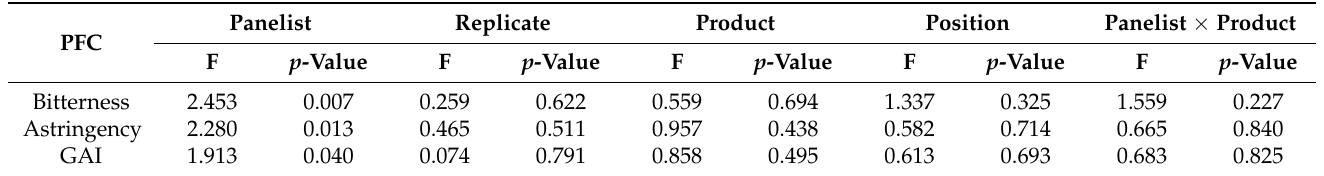
Table 3. Results of three-way ANOVA for the PFC samples (PFC10, PFC15, PFC20, PFC25, and